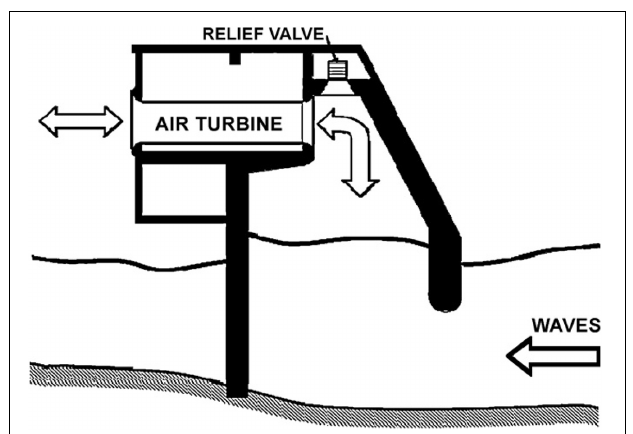
FIGURE 1 | Schematic diagram of OWC (Falcão, 2010).